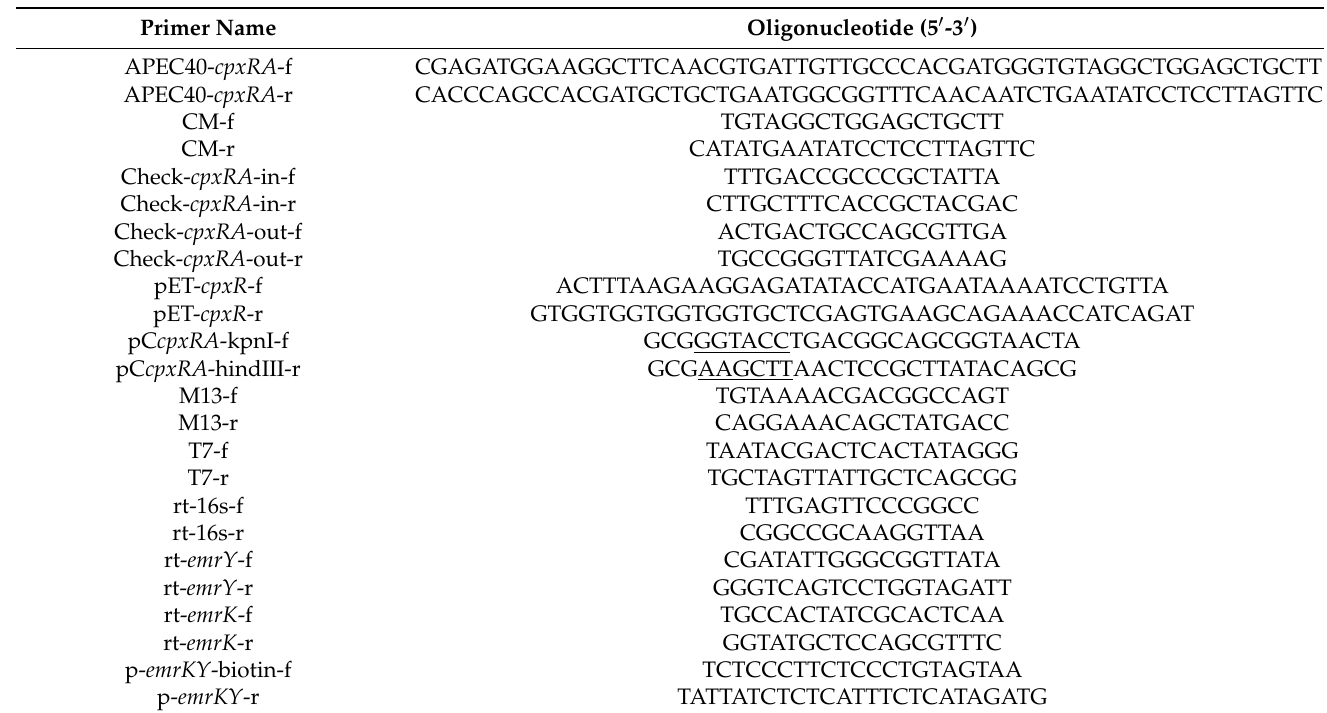
Table 2. Oligonucleotide primers used in this